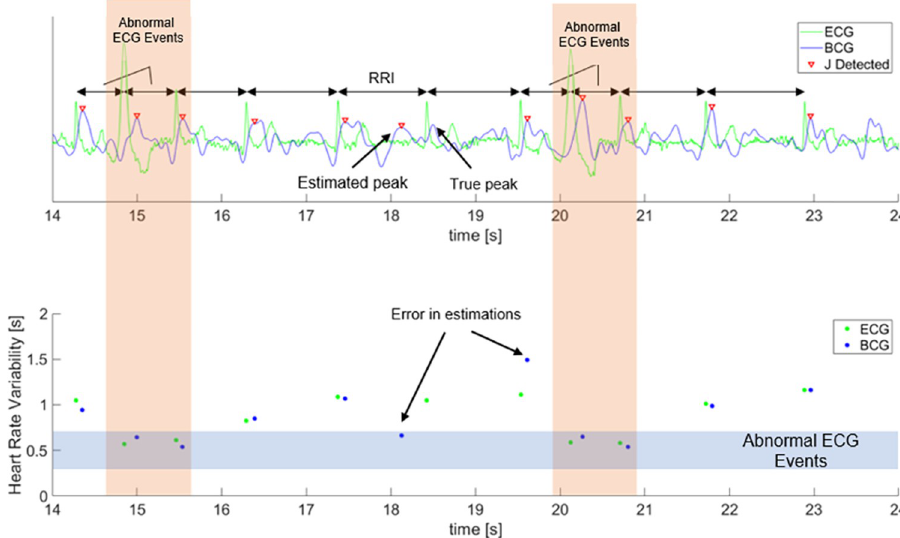
Fig 8. Accurate detection of R peaks from subject with abnormal ECG waves. The occurrences of irregular heartbeats are shown with orange background.